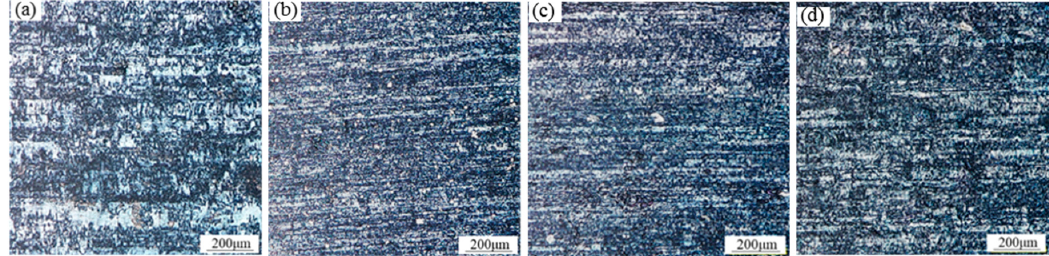
Figure 4. Grain structure after the subsequent cold rolling of the 1060 aluminum alloy cast rolling strip: ( a ) the top surface of the strip with added 0.18 wt% Al-Ti-B refiner and applied conventional treatment; ( b ) the top surface of the strip with added 0.18 wt% Al-Ti-B refiner and applied ultrasonic treatment; ( c ) the top surface of the strip with added 0.12 wt% Al-Ti-B refiner and applied ultrasonic treatment; ( d ) the top surface of the strip with added 0.09 wt% Al-Ti-B refiner and applied ultrasonic treatment.